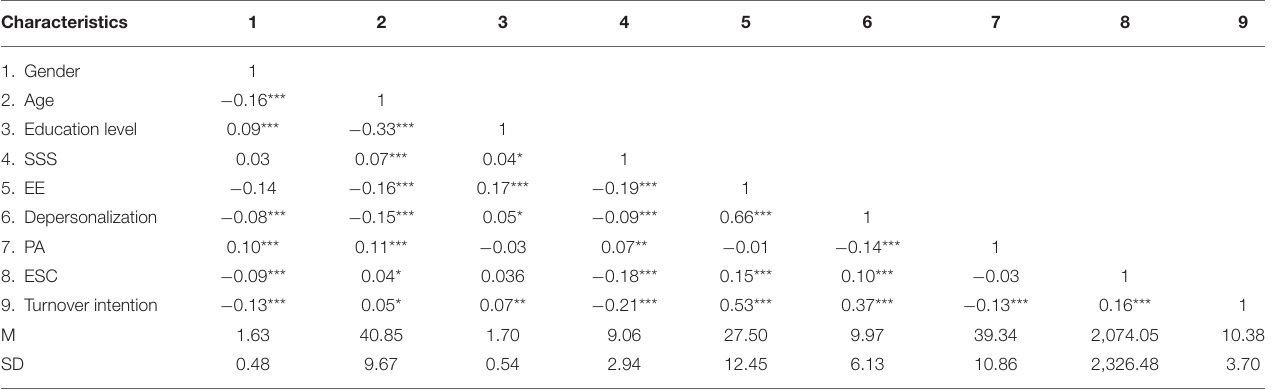
TABLE 1 | Descriptive statistics and correlation among variables ( N = 2,502).